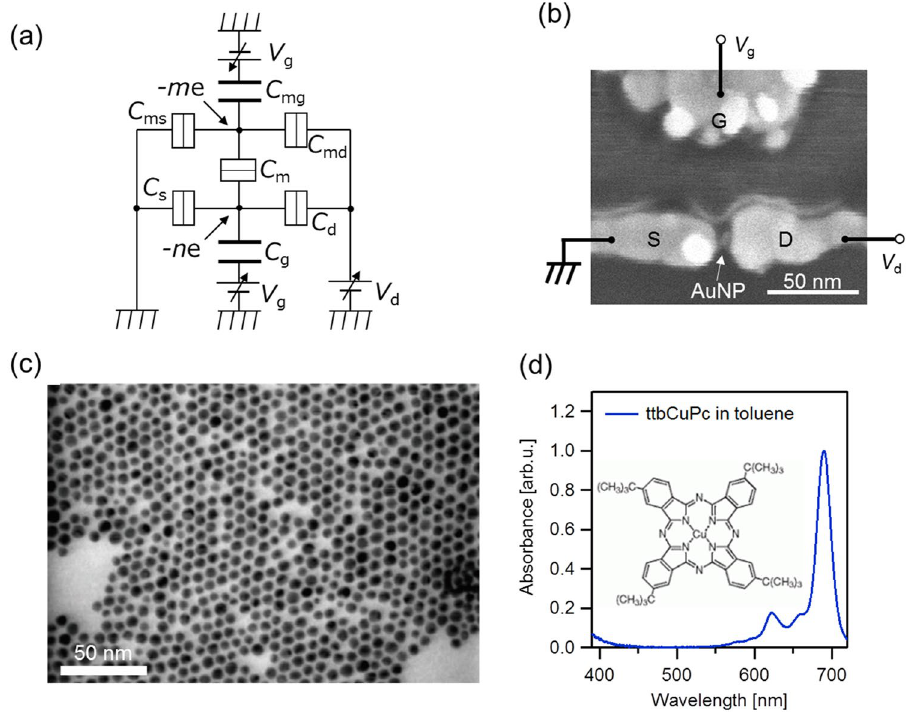
Figure 1. ( a ) Equivalent circuit of MFG-SET. ( b ) SEM image of MFG-SET. The bright spot between the source (S) and drain (D) electrodes is AuNP, which functions as a Coulomb island. ( c ) TEM image of AuNPs used in this study. ( d ) Absorption spectrum of ttbCuPc molecule in a toluene solution. The inset figure shows the molecular